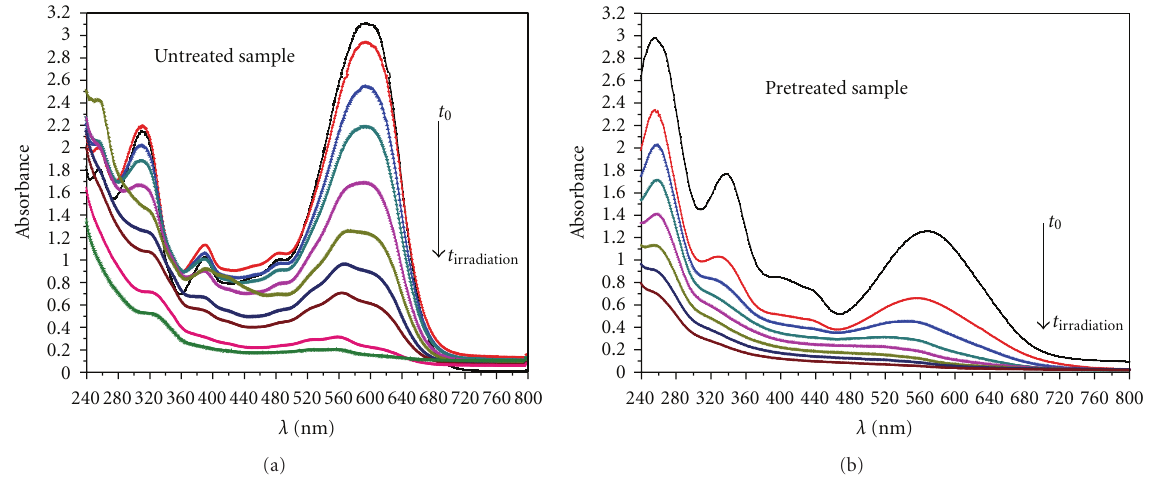
Figure 4: Temporal changes in absorption spectra of untreated (a) and pretreated (b) Reactive Black 5 textile e ffl uent taken at 5–15 min intervals, the irradiation time was 210